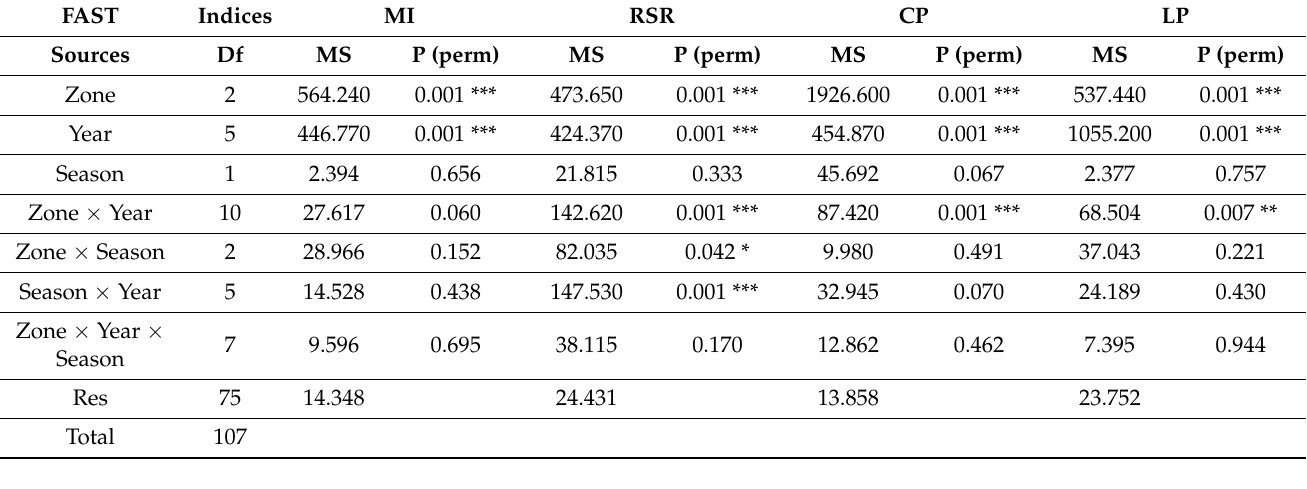
Table 2. PERMANOVA applied on FAST census to assess differences in fish assemblage structure. The indices Carnivores Proportion (CP), Large Proportion (LP), Mean Index (MI), and Relative Species Richness (RSR) were separately analyzed